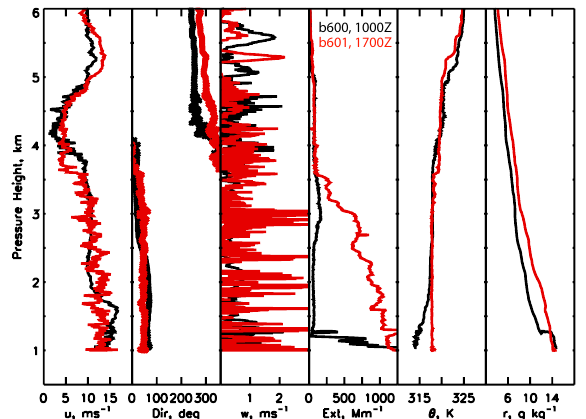
Figure 14. Aircraft measurements from the profile descent of b600 (around 10:00UTC, black) and b601 (around 17:00UTC, red) cor- responding to the tracks, imagery and forecasts shown in Fig. 13. Figure shows wind speed ( u ), wind direction, vertical wind speed ( w ), corrected extinction coefficient (Ext) calculated from the neph- elometer scattering and PSAP absorption, potential temperature, and water vapour mixing ratio ( r ). Note that altitude is shown in pressure height, corresponding to minimum altitudes of 825 and 784m a.g.l. respectively for b600 and